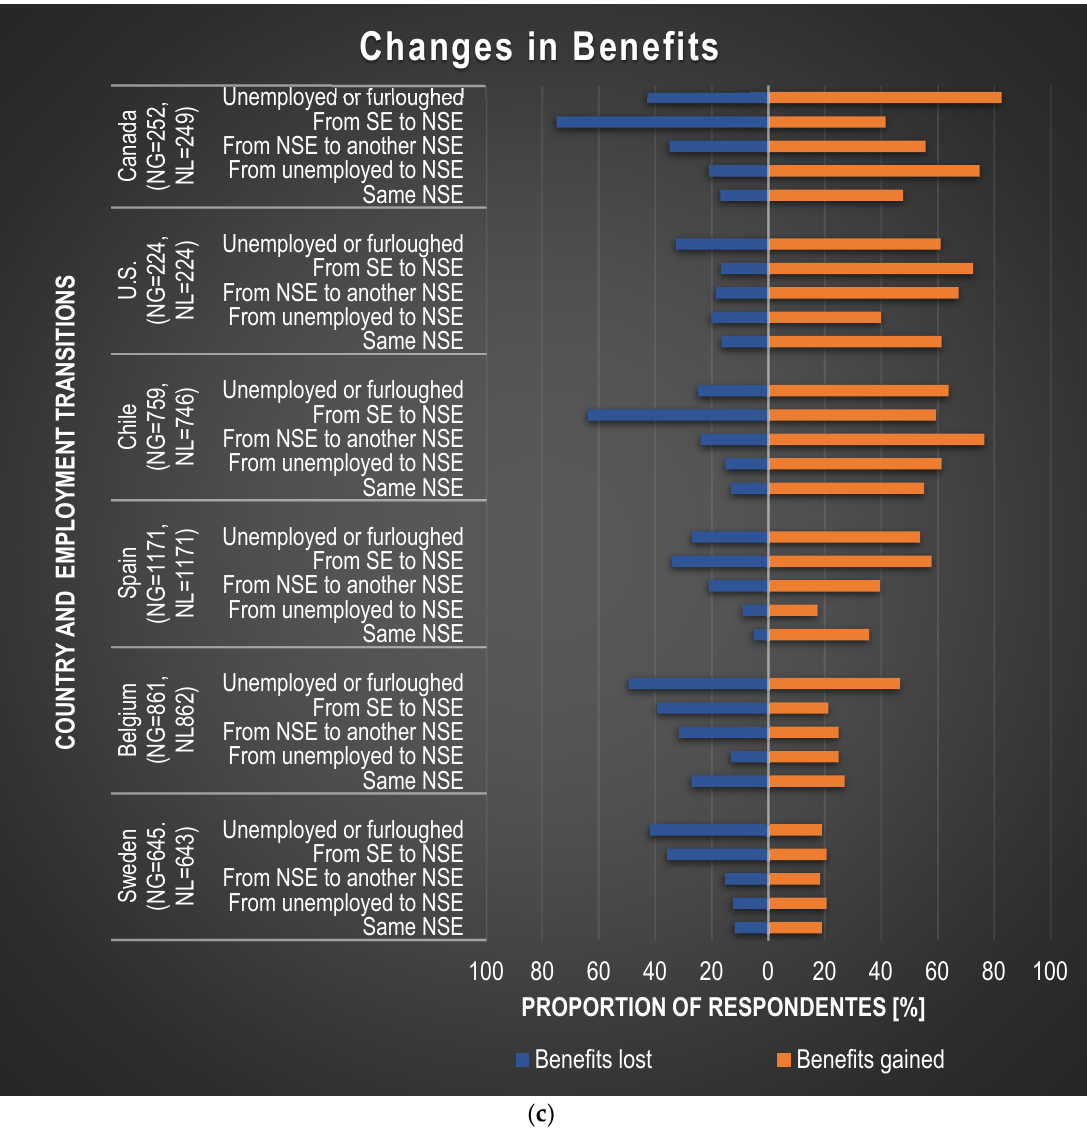
Figure 1. Proportion of respondents indicating changes in work hours, work income, and benefits compared to the job held or situation before the COVID-19 crisis, by country and by employment transition. ( a ) Changes in work hours, ( b ) Changes in work income, and ( c ) Changes in benefits. Notes: N represents the total sample of participants with jointly defined values for the employment transitions and changes in work hours, work income, and benefits questions. More specifically, for figure ( c ) NG represents the total sample of participants who gained benefits and NL the total sample of participants who lost benefits.